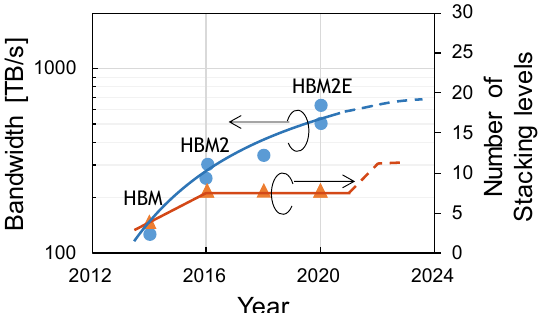
Figure 29. HBMroadmapwithmicro-bumps, whereHBM[82], HBM2[83–85], HBM2E[86,87], Figure 29. HBM road map with micro-bumps, where HBM [82], HBM2 [83–85], HBM2E [86,87], respectively.